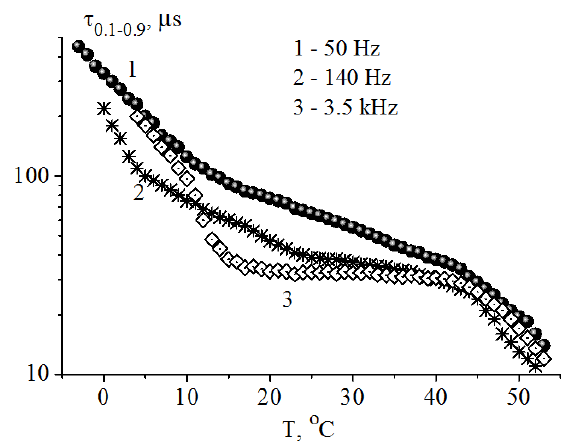
Figure 12. Temperature dependences of the electro-optical response time for the 1.7 μm thick FLC cell with the composition HF-32B. The amplitude of the control voltage (meander) is ±1.5 V. The control voltage frequencies are 50 Hz (curve 1), 140 Hz (curve 2), and 3.5 kHz (curve 3).